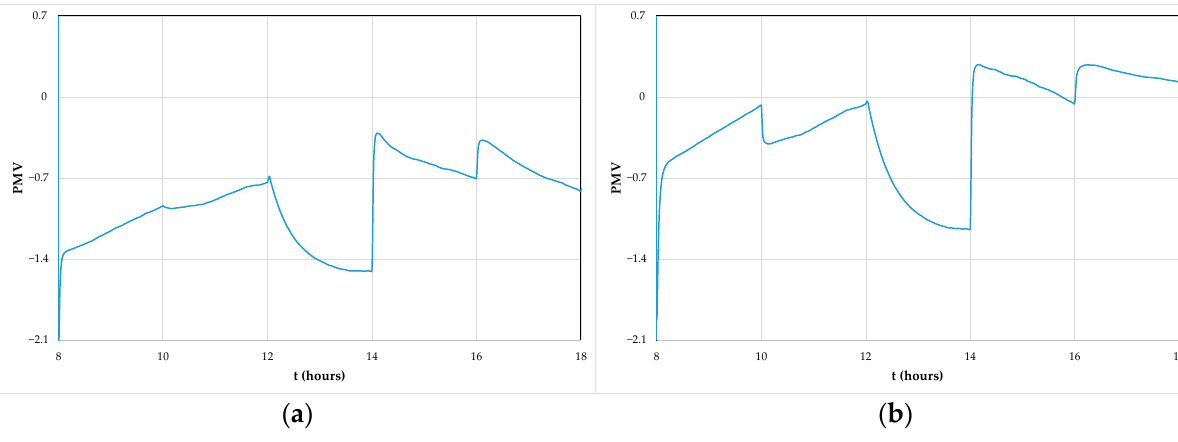
Figure 24. Evaluation of predicted mean vote (PMV) index for the Case A ( a ) and Case B ( b ).